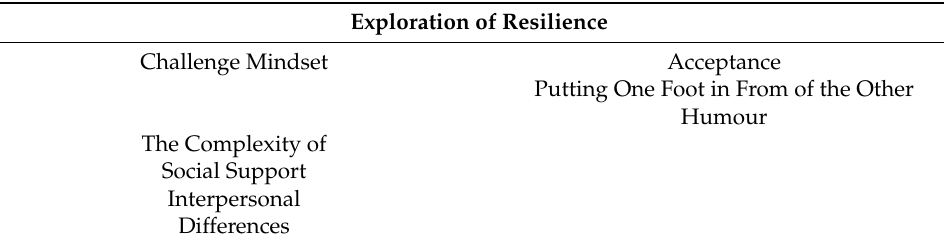
Table 2. A summary of the qualitative results from the video diaries and focus groups (part